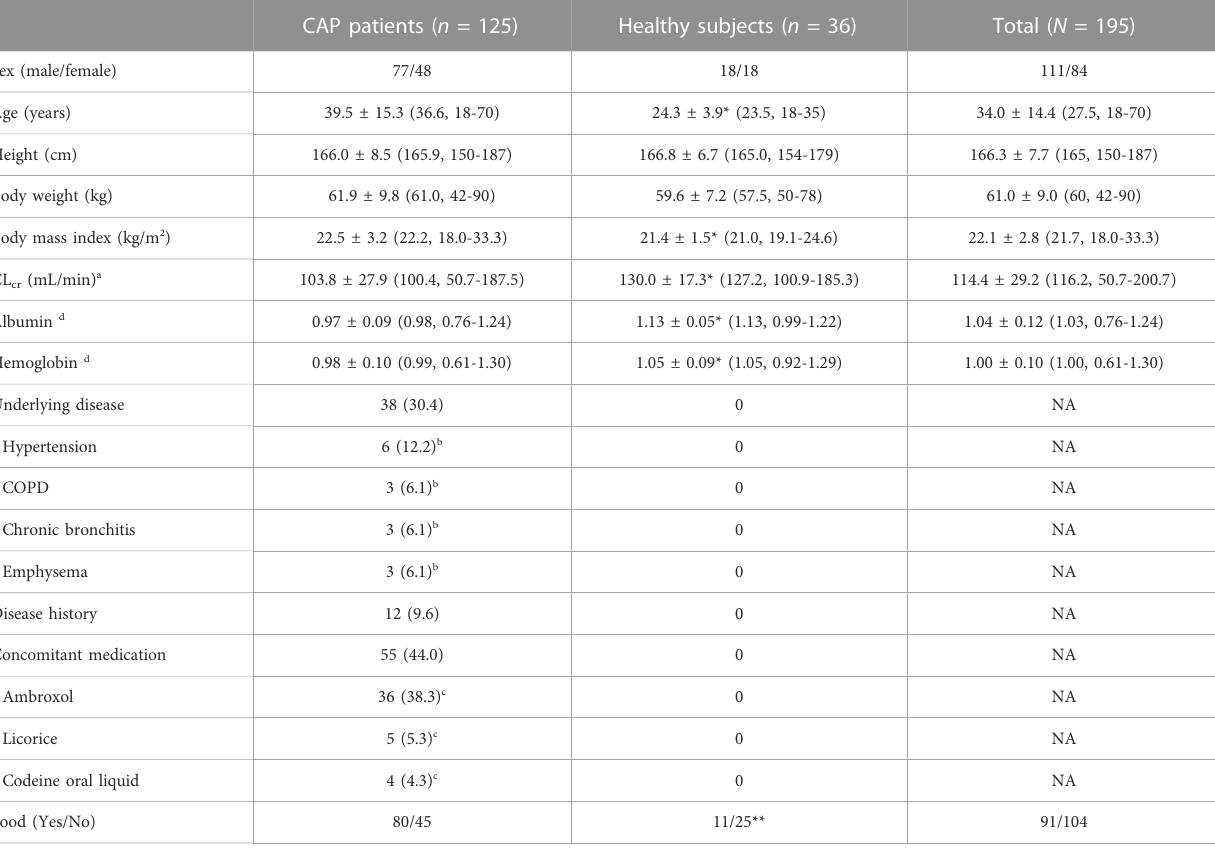
TABLE 1 Baseline characteristics of subjects in phase I to III clinical trials of